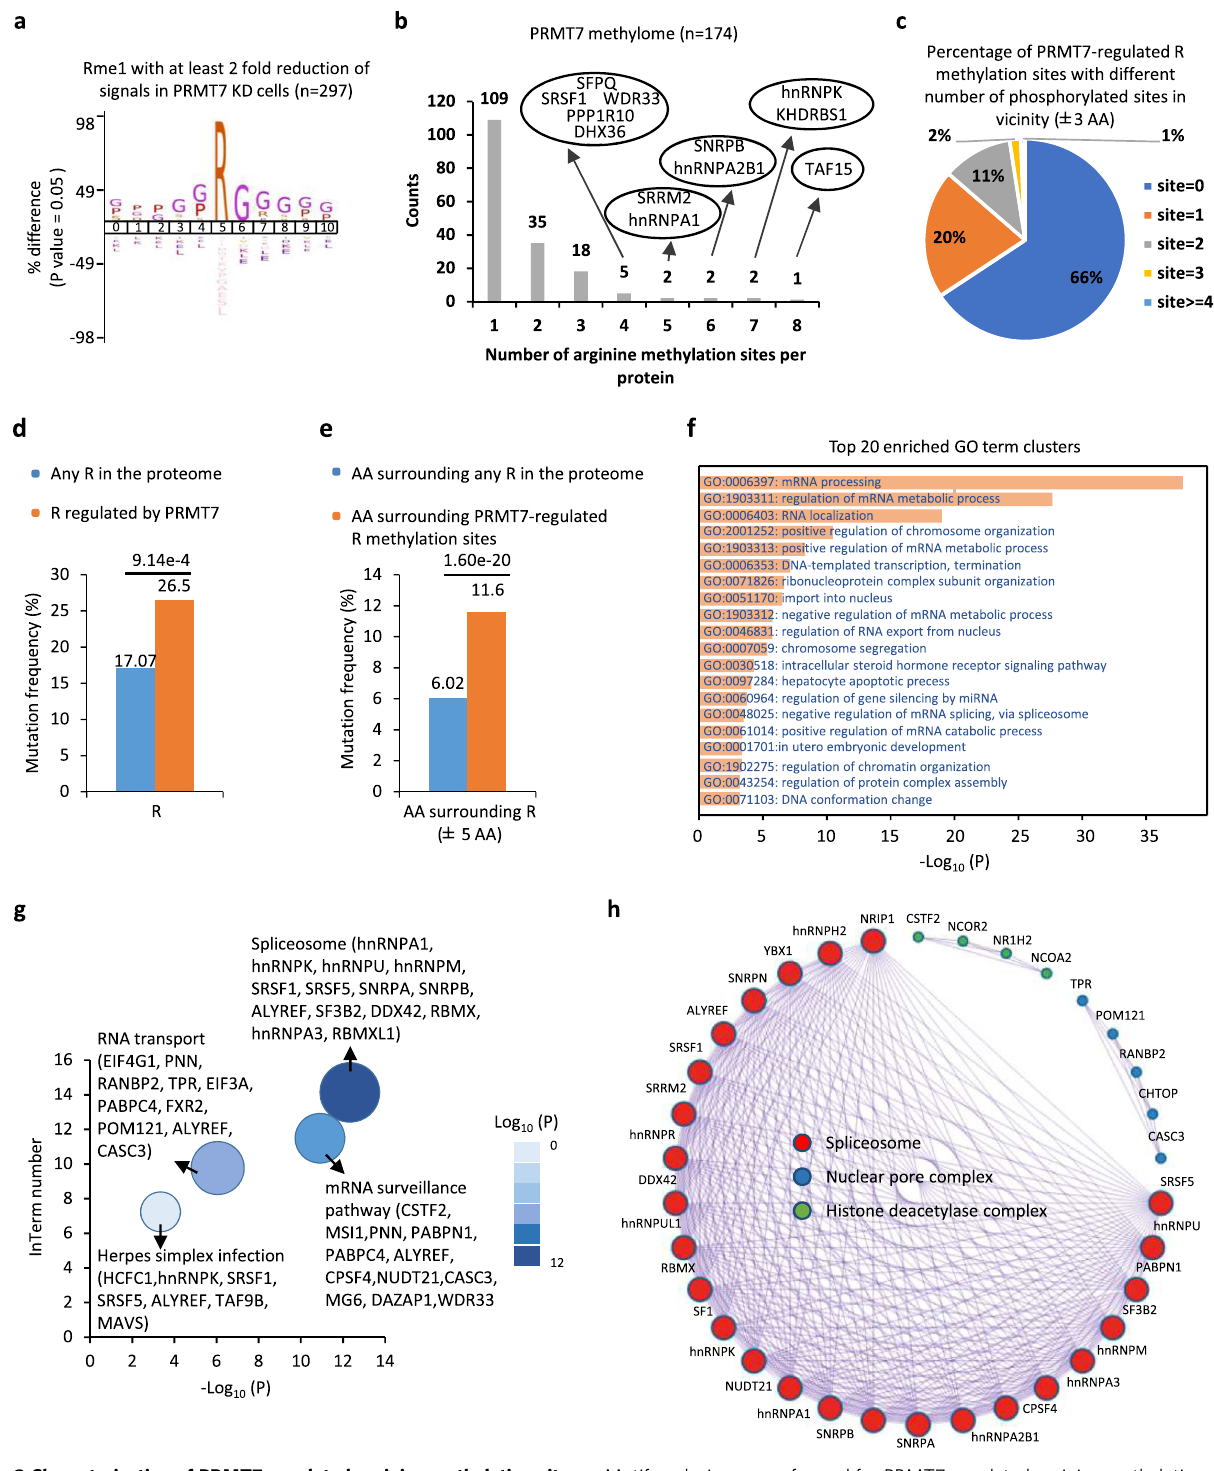
Fig. 2 Characterization of PRMT7-regulated arginine methylation sites. a Motif analysis was performed for PRMT7-regulated arginine methylation sites using iceLogo 84 . b The distribution of proteins in PRMT7 methylome with different number of arginine methylation sites. The proteins with more than two methylation sites were shown in oval. c The percentage of PRMT7-regulated arginine methylation sites with different number of phosphorylation sites ( n = 0, 1, 2, 3 or ≥ 4) in vicinity (±3 amino acid (AA) window) was shown by pie chart. d Rates of somatic mutations at all arginine sites in the proteome or PRMT7-regulated arginine sites in human cancers ( p = 9.14e − 4 by the Fisher ’ s exact test). e Rates of somatic mutations in the vicinity of all arginine sites in the proteome or PRMT7-regulated arginine sites in human cancers (±5 nucleotides) ( p = 1.6e − 20 by the Fisher ’ s exact test). f – h Gene ontology (GO) ( f ), KEGG pathway ( g ), and CORUM 47 ( h ) analysis using Metascape 46 for PRMT7 methylome. Representative terms from the top 20 enriched GO term clusters were shown.